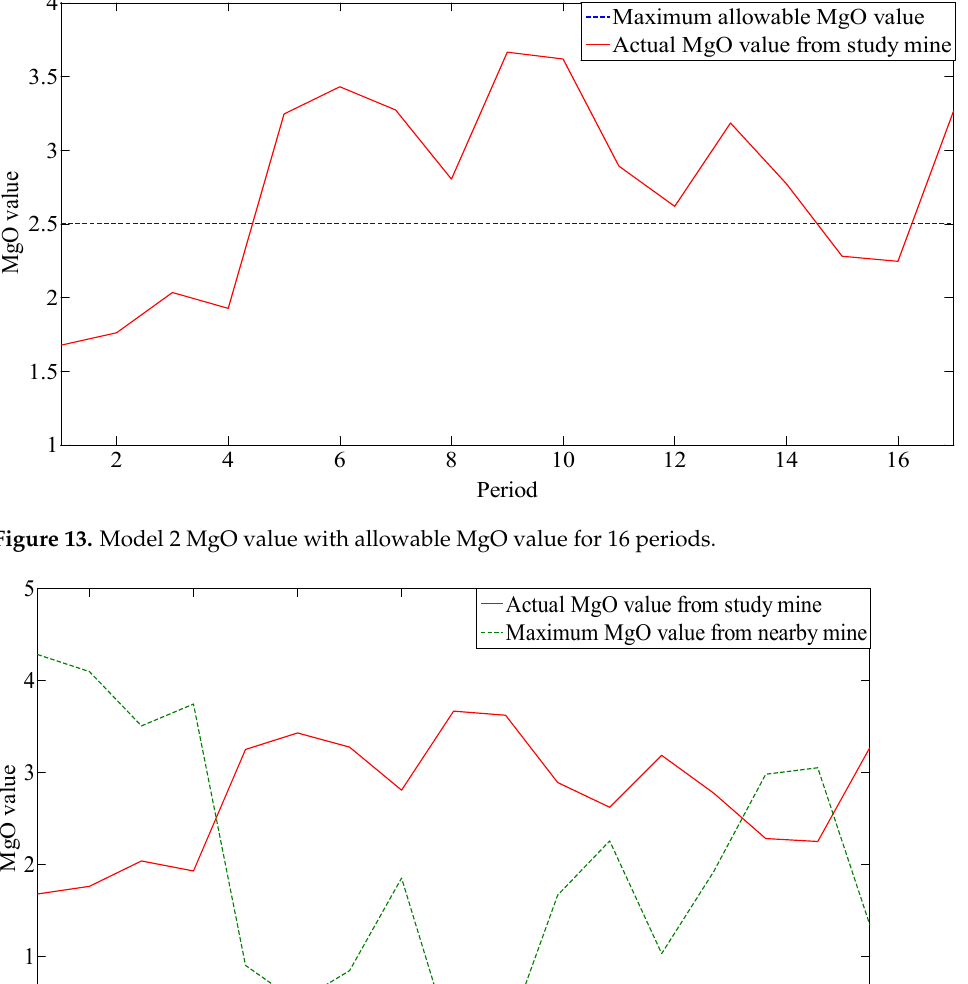
Figure 15. Model 2 final ultimate pit and production schedule (legend represents a period of extrac- tion). Table 3. Production scheduling results of Model 2. Period